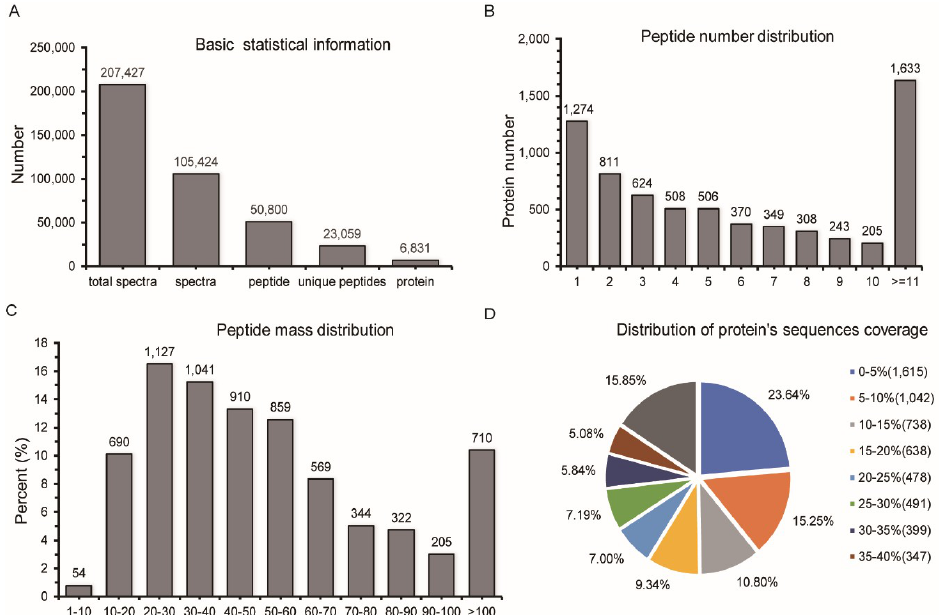
Figure 1. Identification and quantitative evaluation of identified proteins. ( A ) Spectra, peptides, and proteins identified by ProteomeDiscoverer. ( B ) Distribution of peptide numbers as determined by ProteomeDiscoverer. ( C ) Distribution of identified proteins according to molecular mass. ( D ) Distribution of identified protein sequences.